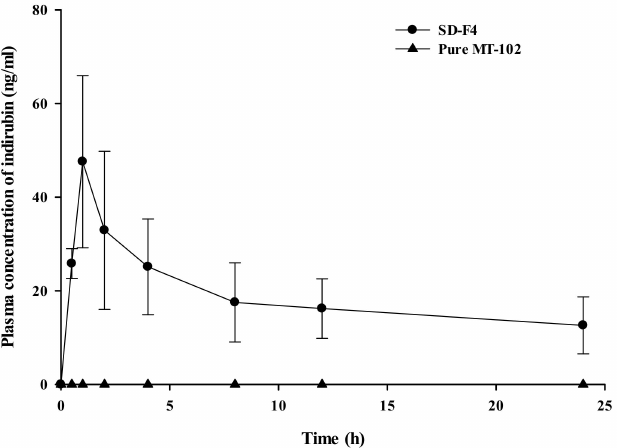
Figure 10. Plasma concentration–time profiles of indirubin after oral administration of SD-F4 or pure MT-102 to rats (mean ± s.d, n = 5). The dose was equivalent to 500 mg/kg of MT-102. Table 3. Pharmacokinetic parameters of indirubin after oral administration of SD-F4 or pure MT-102 (pure extract) to rats (mean ± s.d., n = 5). The dose was equivalent to 500 mg/kg of MT-102. Formulation AUC (ng × h/mL) C max (ng/mL) T max (h) SD-F4 448.5 ± 156.8 49.28 ± 15.43 0.9 ± 0.2 Pure MT-102 ND ND ND ND: Not